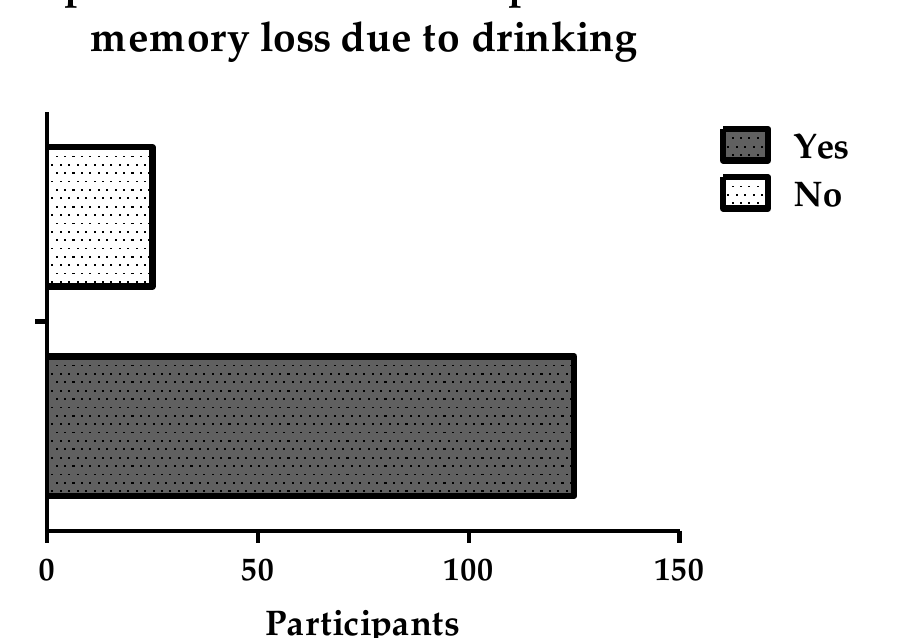
Figure 9. Participants’ experiences of blacking out, passing out, or memory loss because of alcohol consumption.